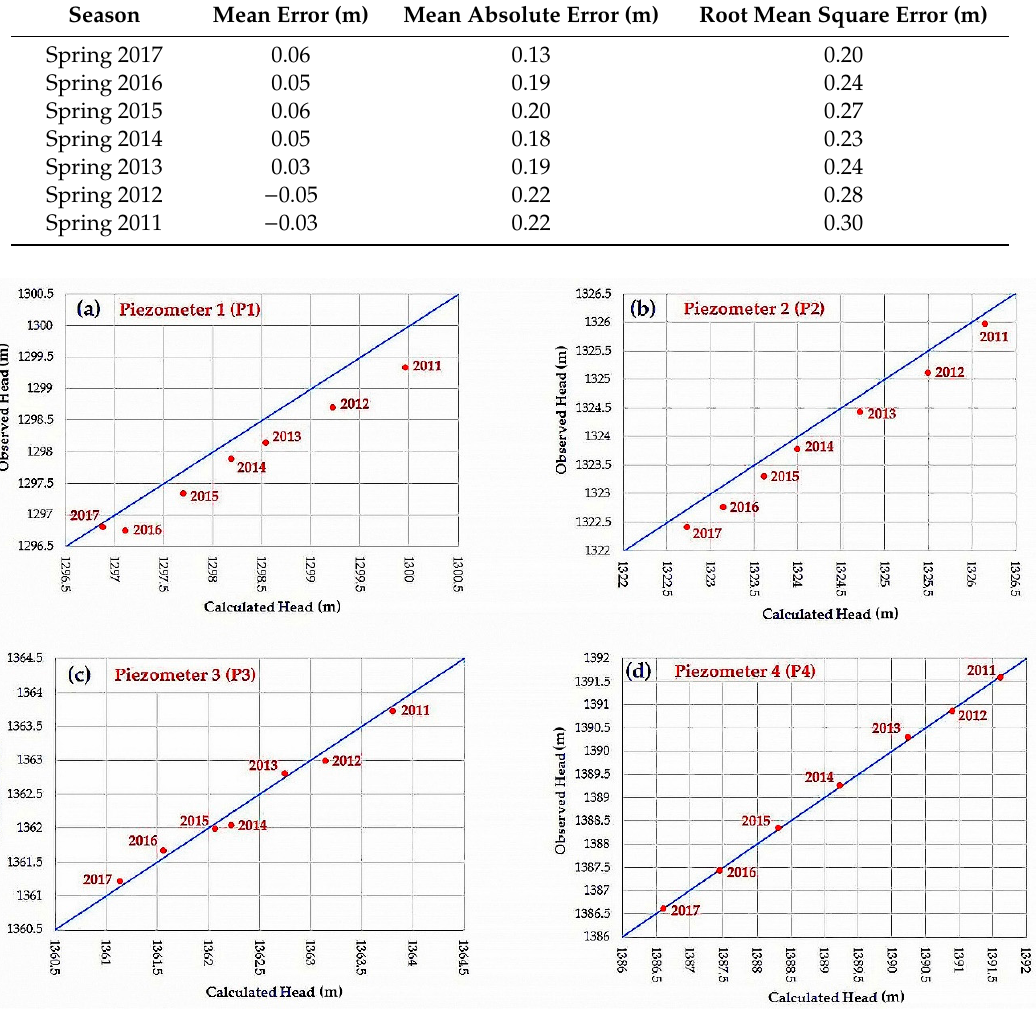
Figure 17. Difference between observed and calculated head values in four selected piezometers include ( a ) piezometer 1; ( b ) piezometer 2; ( c ) piezometer 3; and, ( d ) piezometer 4, at the end of model verification for a 7-year period.